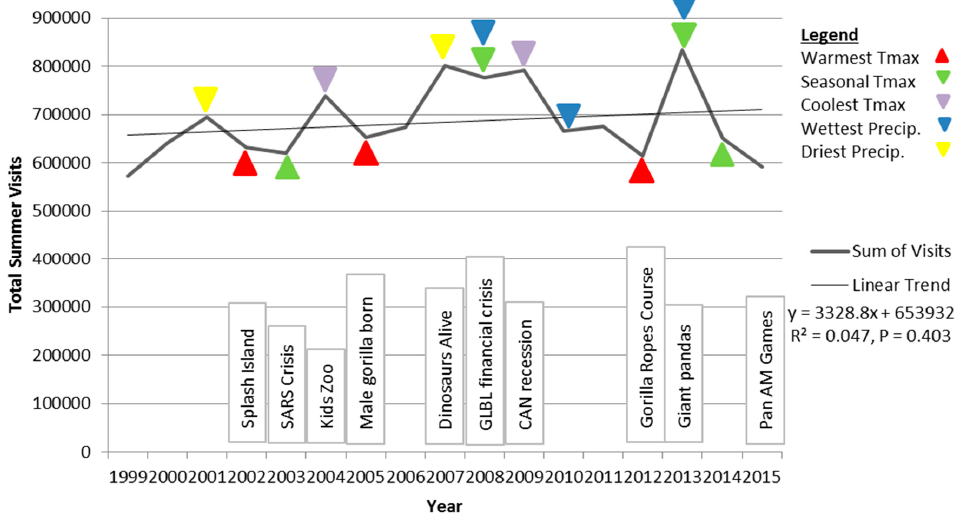
Figure 4. Total zoo visitation by year for the summer season, indicating climatic anomalies, climate normals, and other non-climatic factors from 1999 to 2015.